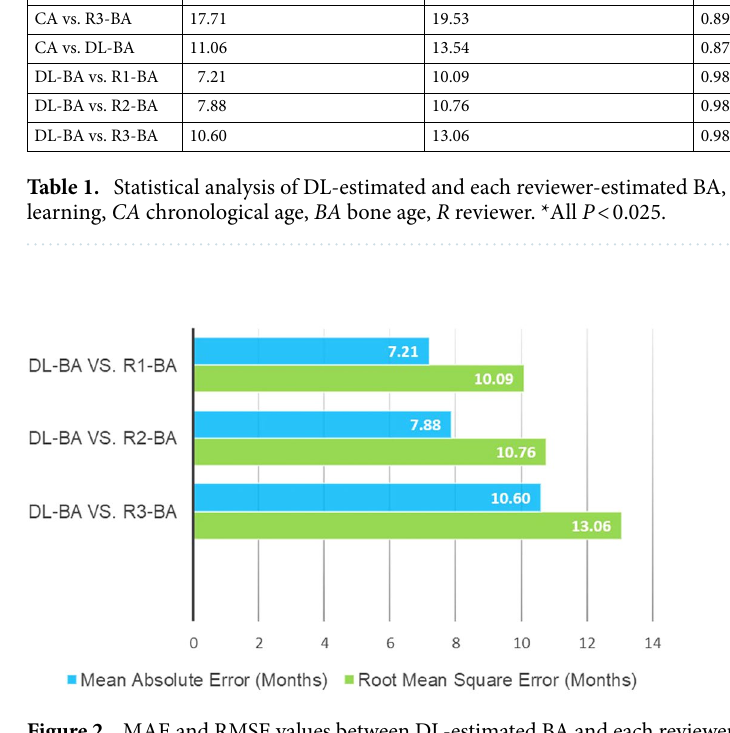
Figure 2. MAE and RMSE values between DL-estimated BA and each reviewer-estimated